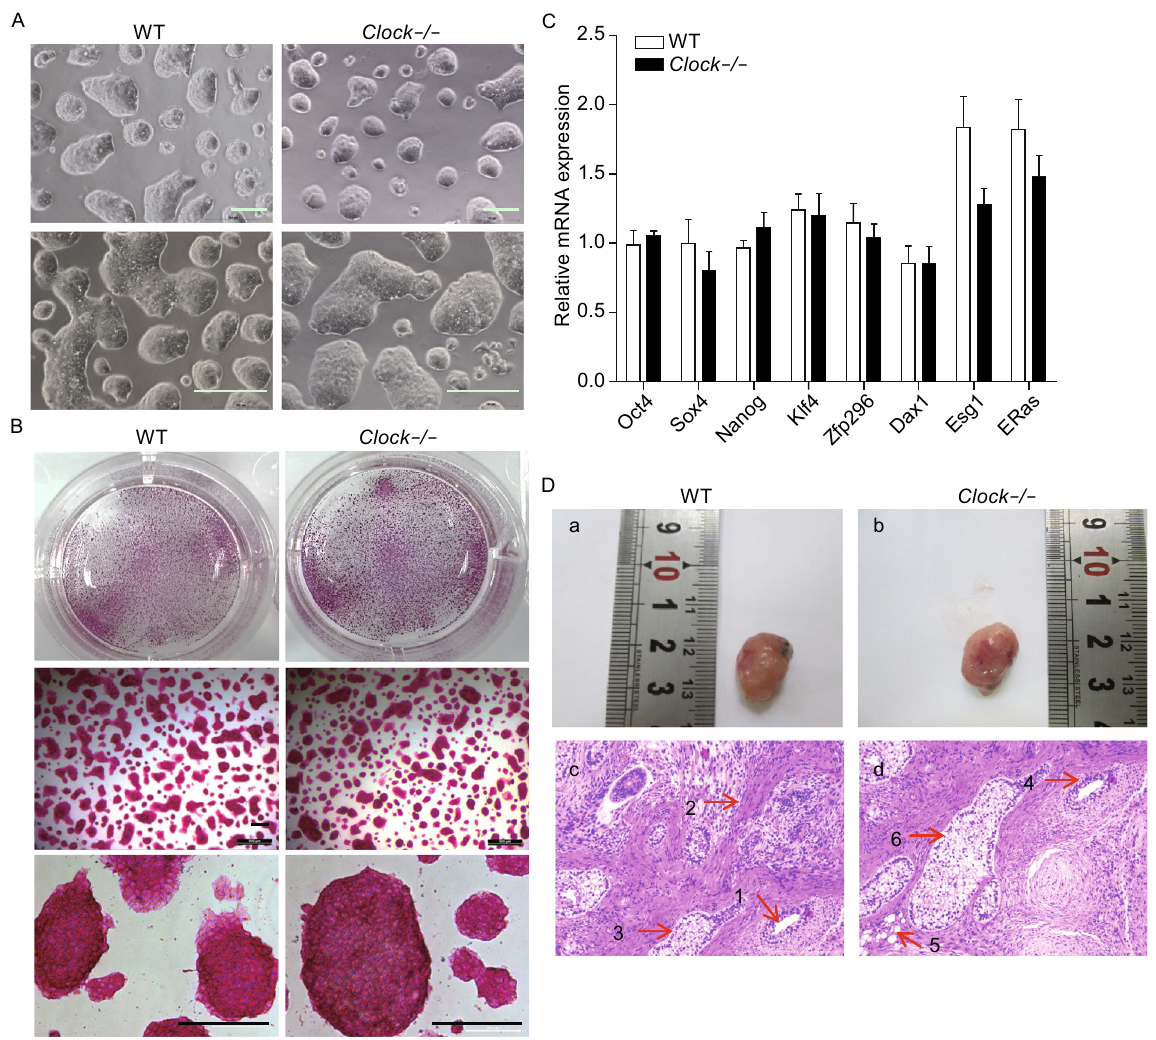
Figure 2. Knockout of Clock did not affect pluripotency of mESCs. (A) Phase images of wild type and Clock -/- mESCs exhibited compact and round clonal morphology. Bars, 200 µm. (B) Both wild type and Clock -/- mESCs stained strongly for alkaline phosphatase. The upper two images represent macroscopic views of a 12-well plate system. Bars, 400 µm. (C) Relative mRNA expression of pluripotent markers Oct4, Sox2, Nanog, Klf4, Zfp296, Dax1, Esg1, and Eras in wild type and Clock -/- mESCs. The mRNA expression levels were normalized to that of the endogenous GAPDH . Data represent an average of three independent experiments and are expressed as means ± S.D. Statistical signi fi cance was calculated using the Student ’ s t -test: * denotes P <